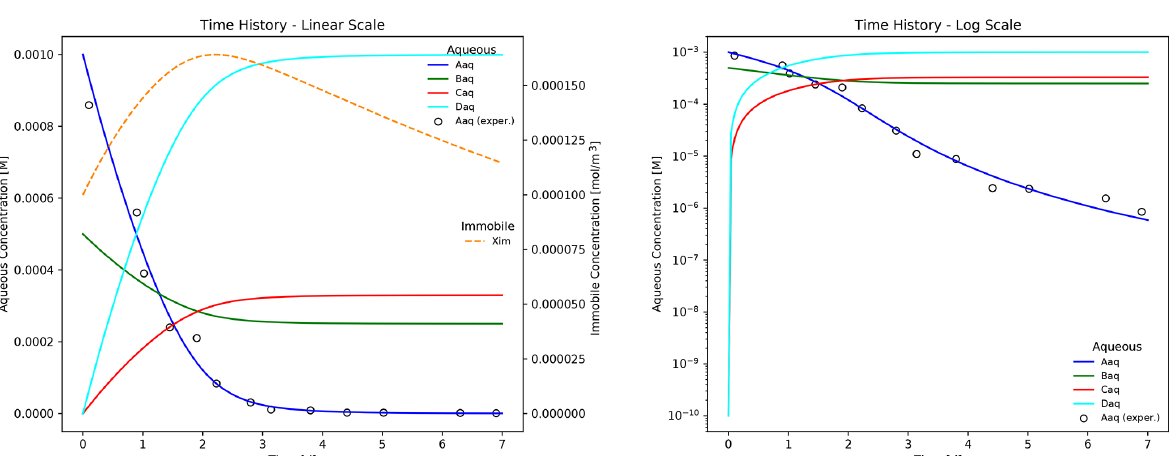
Figure 4. Improved match to the batch experiment results for species A aq after incorporating the Hill function in Eq. (15). Compare with the log-scale plot (without the Hill function) in Fig.